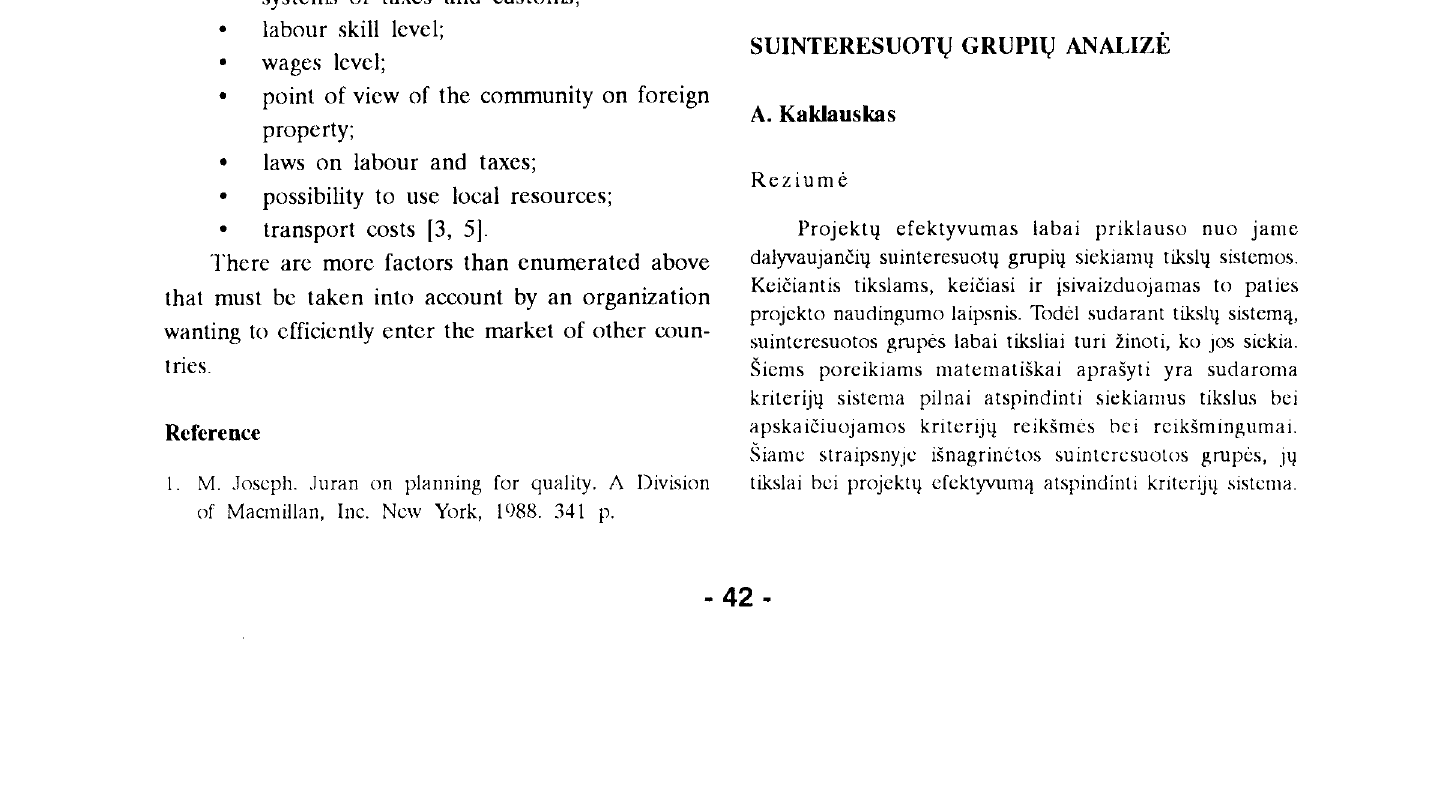
Fig. 7. Fom1ation of feasible strategy versions of an